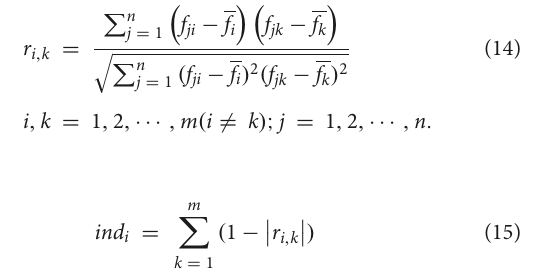
independence of the i th feature ind i can be evaluated